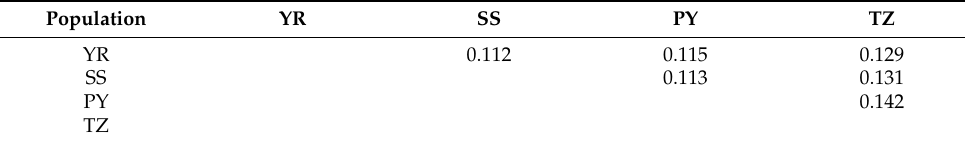
Table 3. Genetic differentiation coefficient of four populations of Coilia nasus